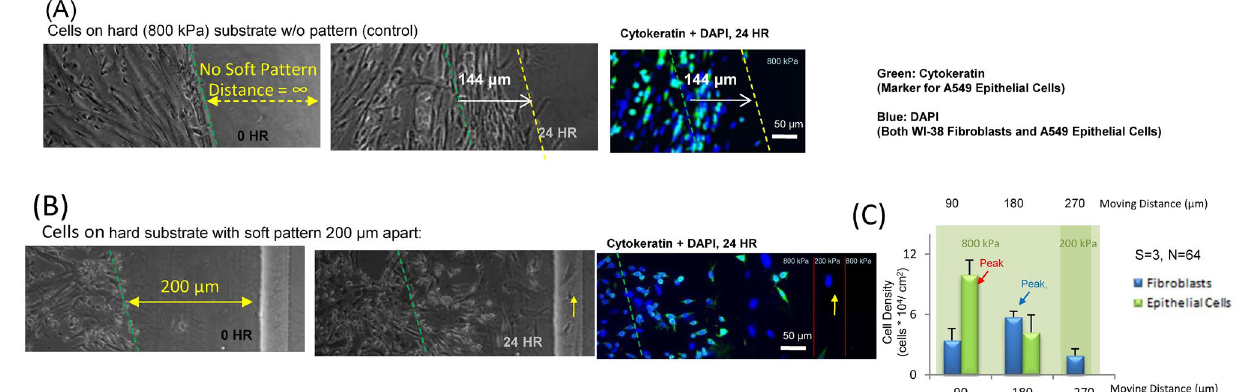
Figure 6. A549 epithelial cells and WI-38 fibroblasts co-cultured motility for the horizontal configuration with cells moving across the width of the rectangular strip of our HSH system. ( A ) The co-culture was released and recorded after 24 h for the 800 kPa PDMS substrate with no soft region as a control. ( B ) The co-culture was released at a distance of 200 μm away from the closest edge of the soft pattern and recorded after 24 h, and then the movement was quantified. Yellow arrow indicates the cell that traveled the longest distance in the image. ( C ) Green pseudo-coloring for was for Cytokeratin and A549 epithelial cells and blue pseudo-coloring was for DAPI and the nucleus with n = 3 and a total cell count of 66. The P value comparing the fibroblasts and the epithelial cells distribution after 24 h was 0.00067 for 200